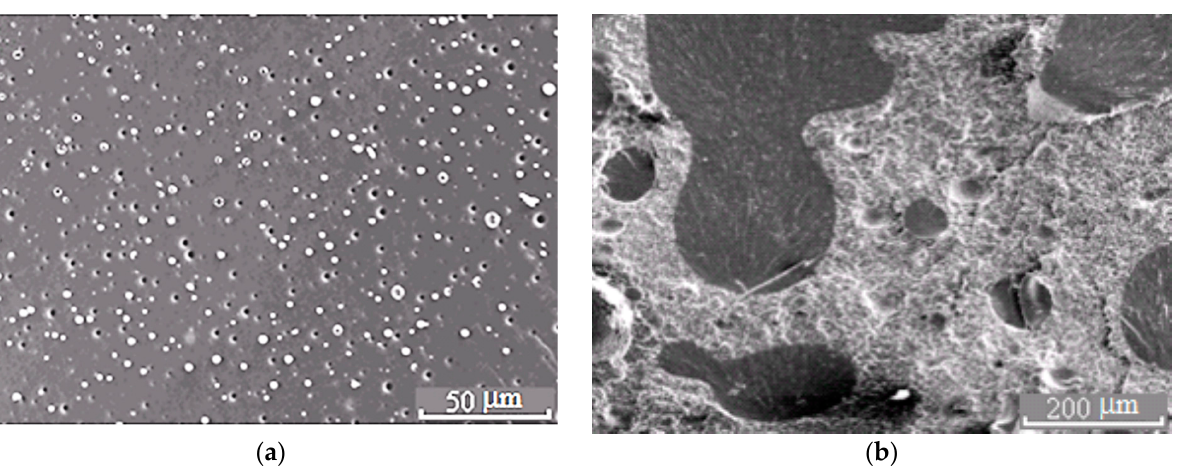
Figure 4. PDs of EO mixtures with PSU at α = 0.25 ( a ) and with PES at α = 0 ( b ). Regions I and II—structures of the “matrix- inclusion” type (sea-island); III—phase reversal region. The compositions of studied systems are marked on the isotherm at 160 ° С .